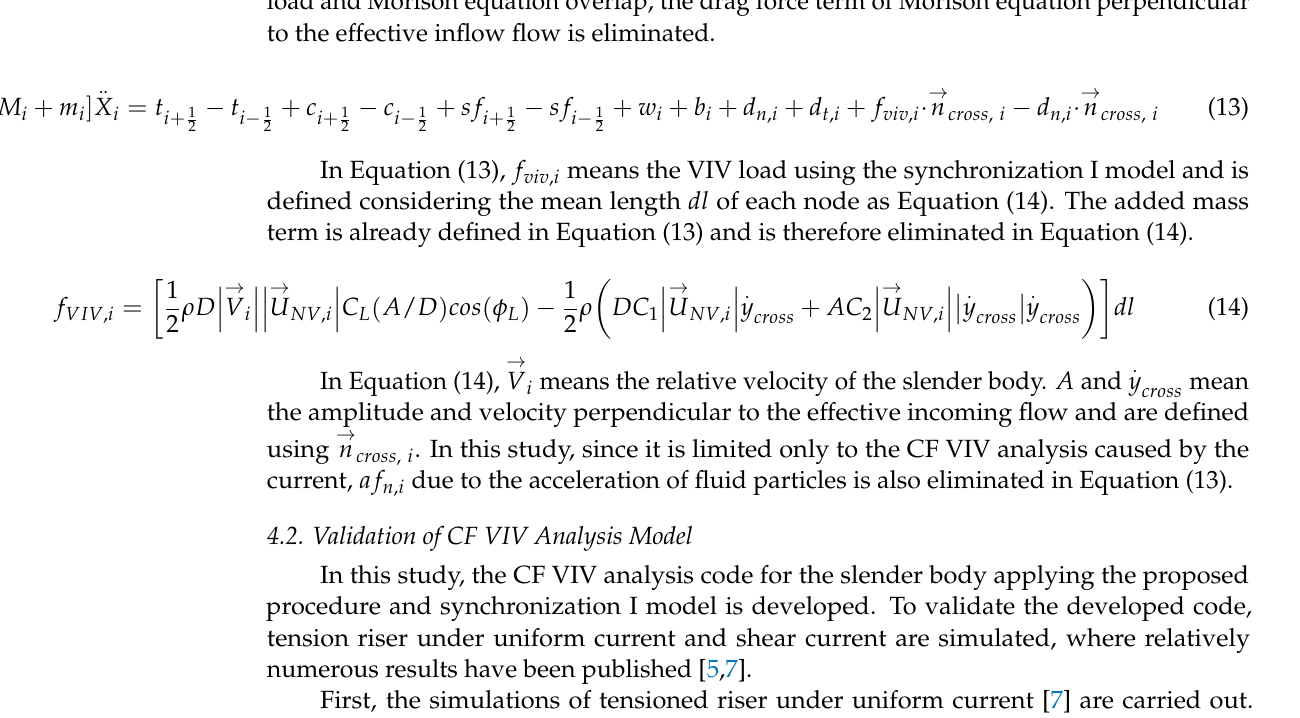
Figure 14. Definition of effective incoming flow velocity 𝑈(cid:4652)(cid:4652)⃗ (cid:3015)(cid:3023) , (cid:3036) and unit vector normal to 𝑈(cid:4652)(cid:4652)⃗ (cid:3015)(cid:3023) , (cid:3036) .